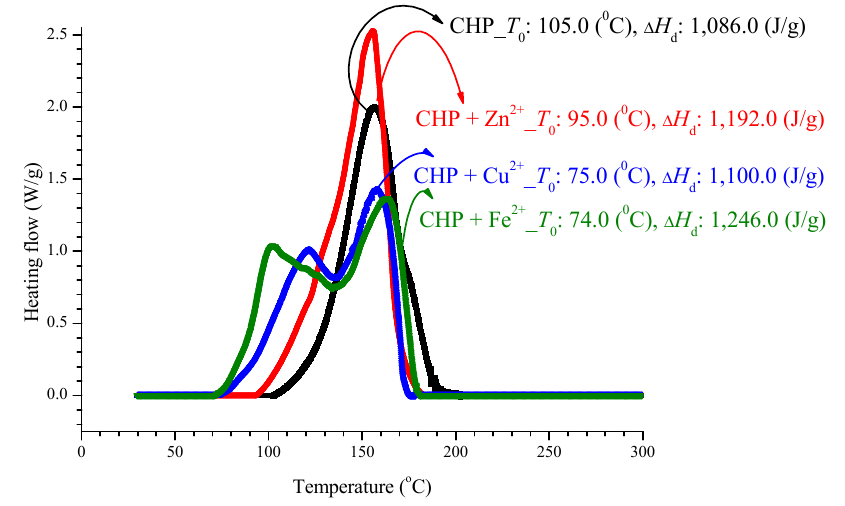
Figure 2. Heat flow versus temperature plot for 80.0 mass% CHP mixed with ZnBr 2 , CuBr 2 , or FeBr 2 , tested using differential scanning calorimetry (DSC) analysis at a heating rate of 4.0 °C/min.